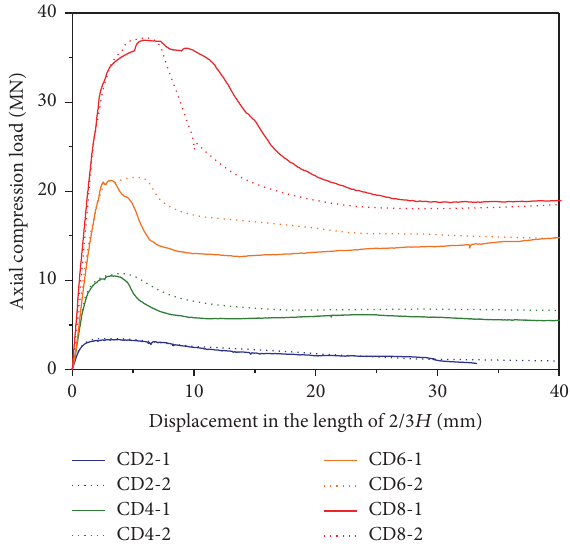
Figure 4: Load-deformation curves of